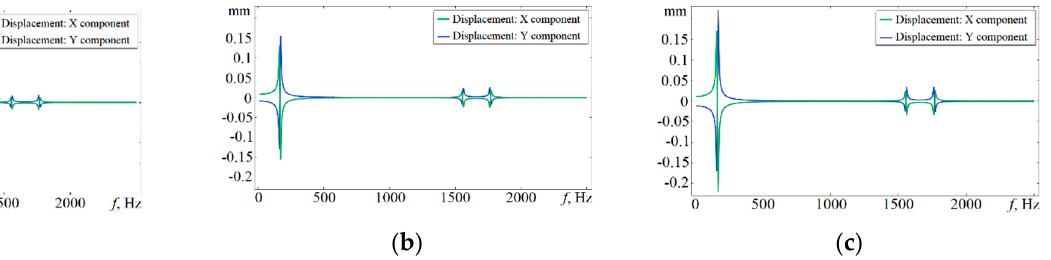
Figure 5. Frequency responses of displacement of the stator of the investigated motor with harmonic distortion of the supply voltage: ( a ) I g3 = I g5 = 0 A ; ( b ) I g3 = 8.8 A , I g5 = 3.3 A ; ( c ) I g3 = 15.4 A , I g5 = 7.7 A .